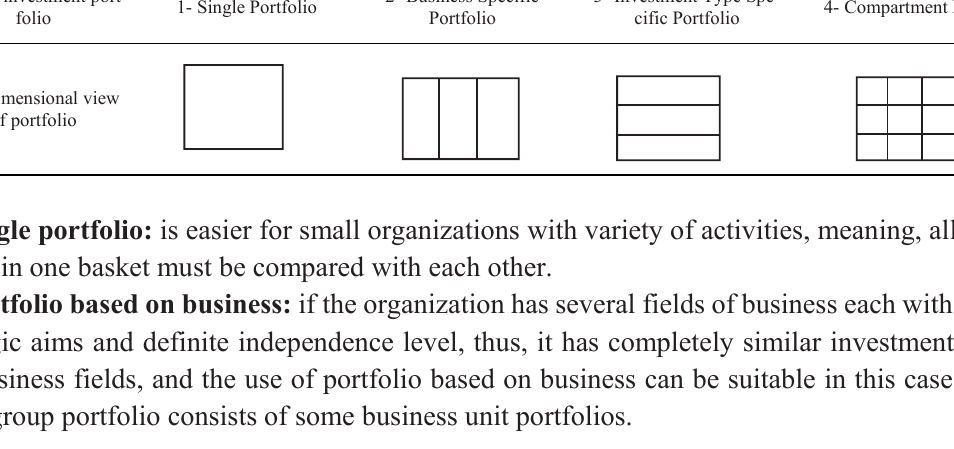
Types of investment portfolio (Martikainen, 2002) Type of investment port- folio Two dimensional view of